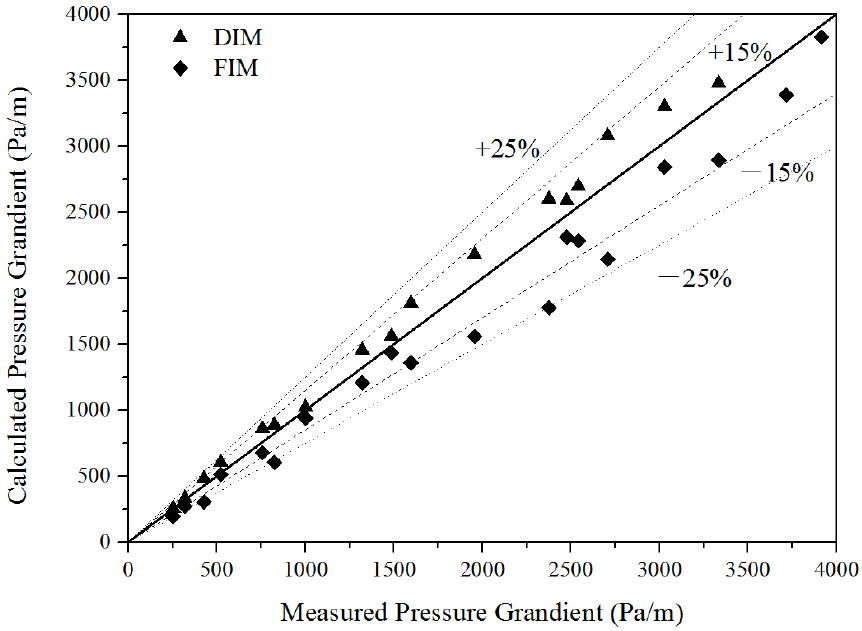
Figure 5. Comparison between prediction and experiment data of the pressure gradient for the No. 1 experiment.